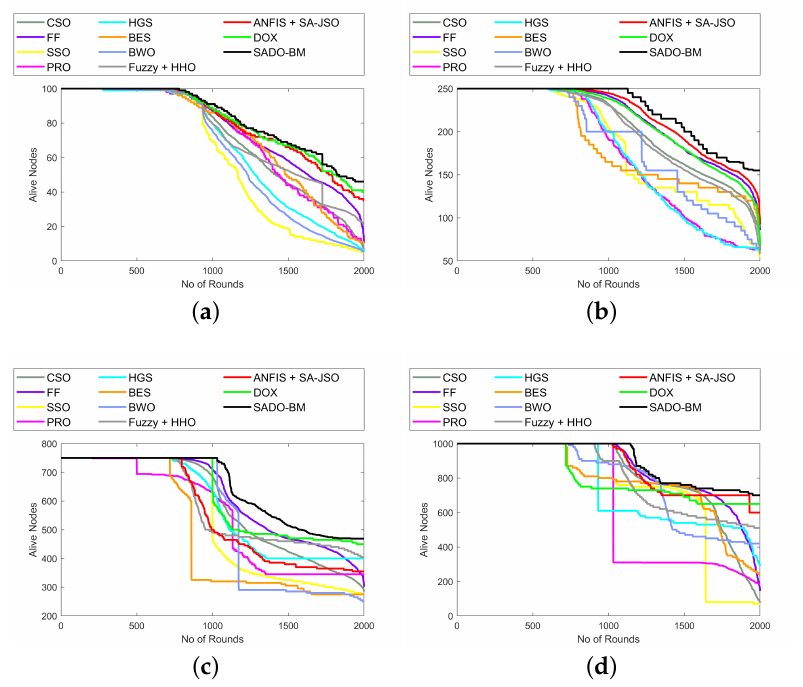
Figure 6. Alive node analysis of SADO-BM over other models for node counts ( a ) 100, ( b ) 250 ( c ) 750, and ( d )